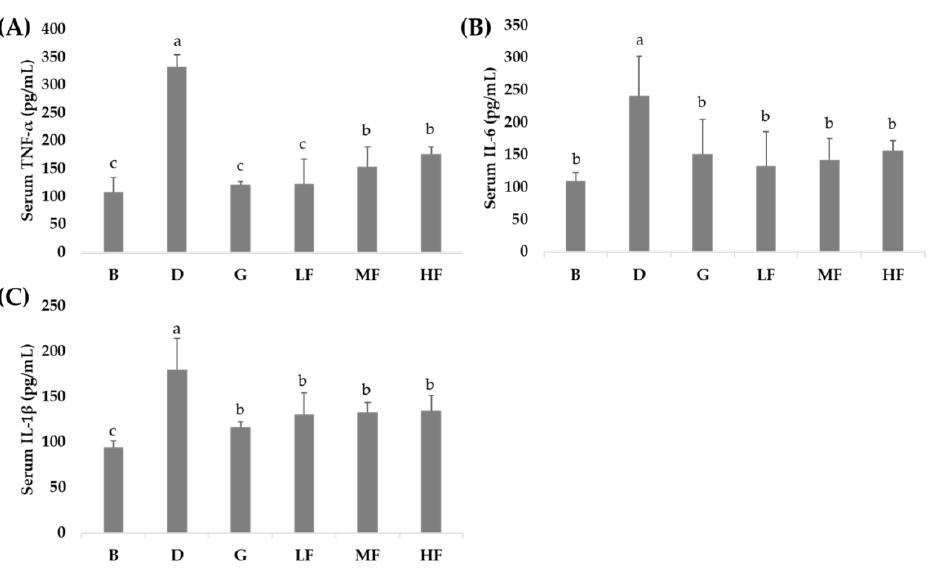
Figure 2. E ff ects of GBR and FGBR on the serum levels of tumor necrosis factor (TNF)- α ( A ), interleukin (IL)-6 ( B ) and IL-1 β ( C ) in F344 rats. The bars represent the mean ± SD ( n = 3). Values with the same letter are not significantly di ff erent from one another as determined by Duncan’s multiple range test, p < 0.05. All rats except those in group B were administered with DMH / DSS. B (blank) and D (control): AIN-93G diet; G: AIN-93G containing 10% GBR; LF: AIN-93G containing a low dose (2.5%) of FGBR; MF: AIN-93G containing a medium dose (5%) of FGBR; HF: AIN-93G containing a high dose (10%) of FGBR.